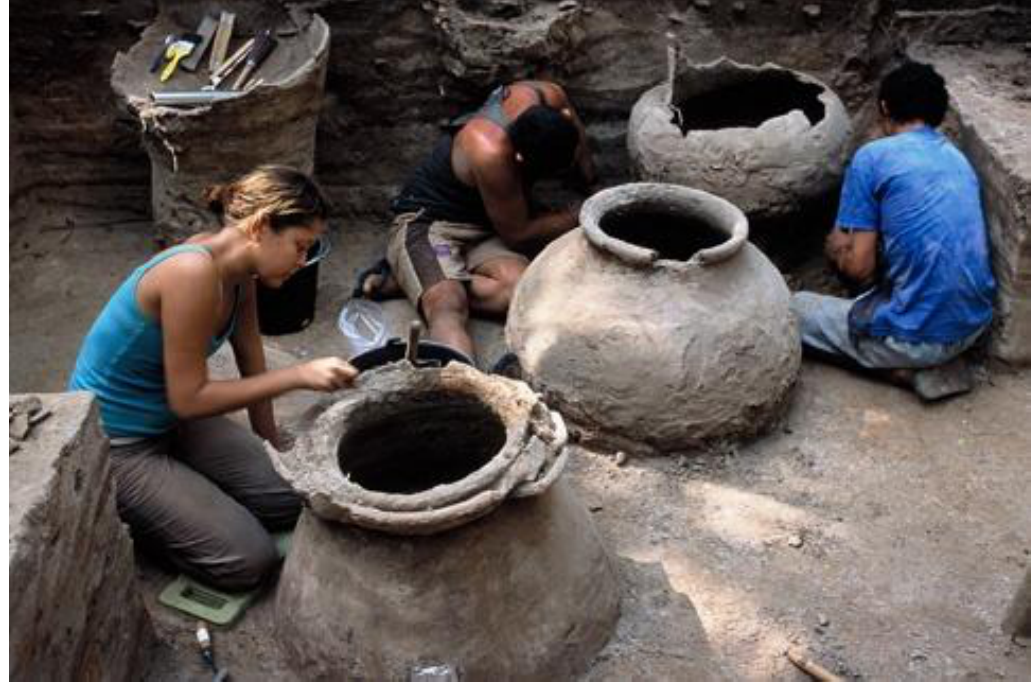
Figure 5. Excavation of a Marajoara mound; Camutins site. Photograph by Carlos Mora, 2002.